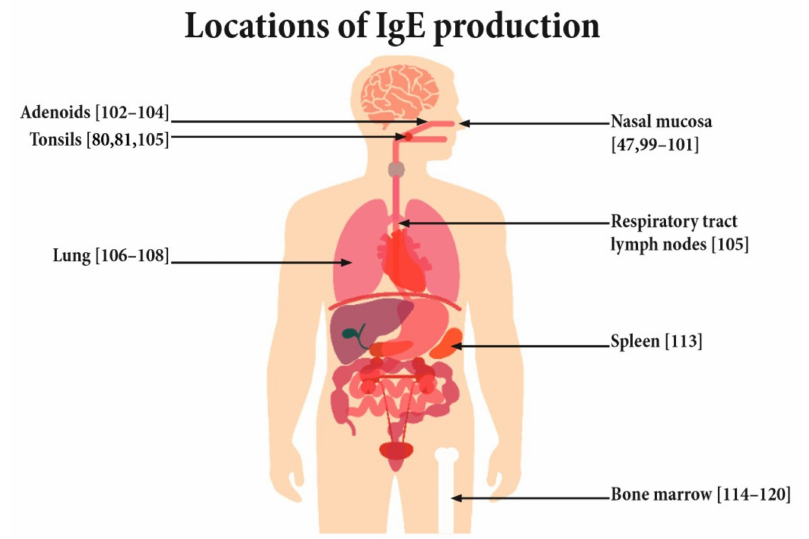
Figure 3. Potential sites of IgE